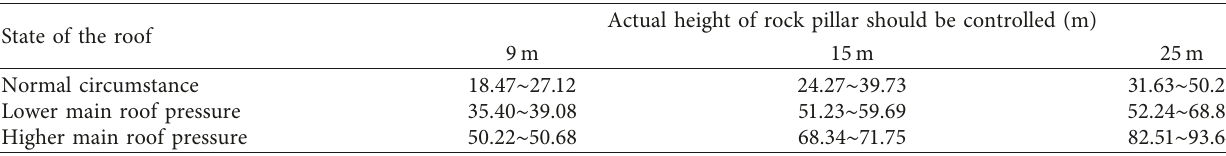
Table 6: Rock pillar height which needs to be controlled under different conditions of main roof movement in different thick coal seams. State of the roof